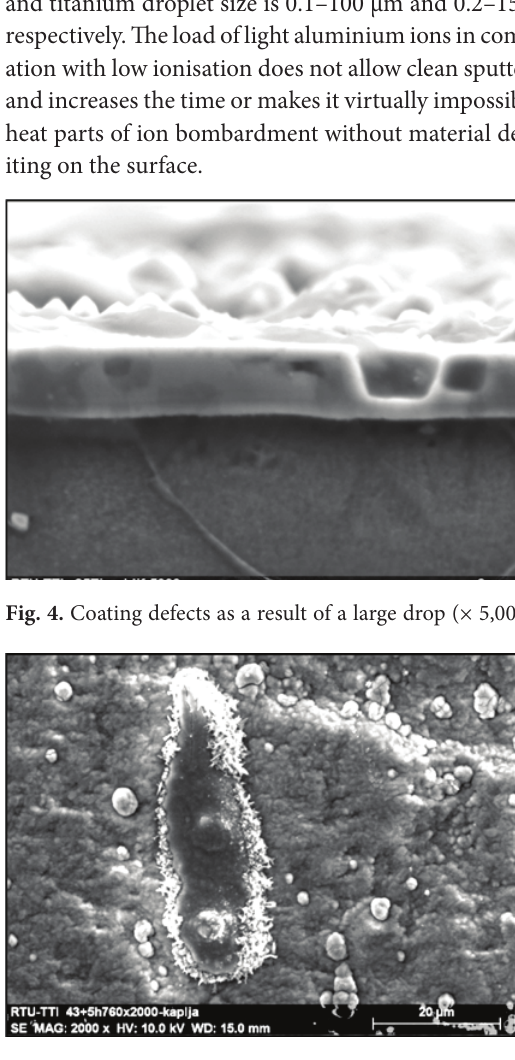
fig. 5. Formation of needle-shaped titanium oxide on the limits of a large drop (× 2,500)